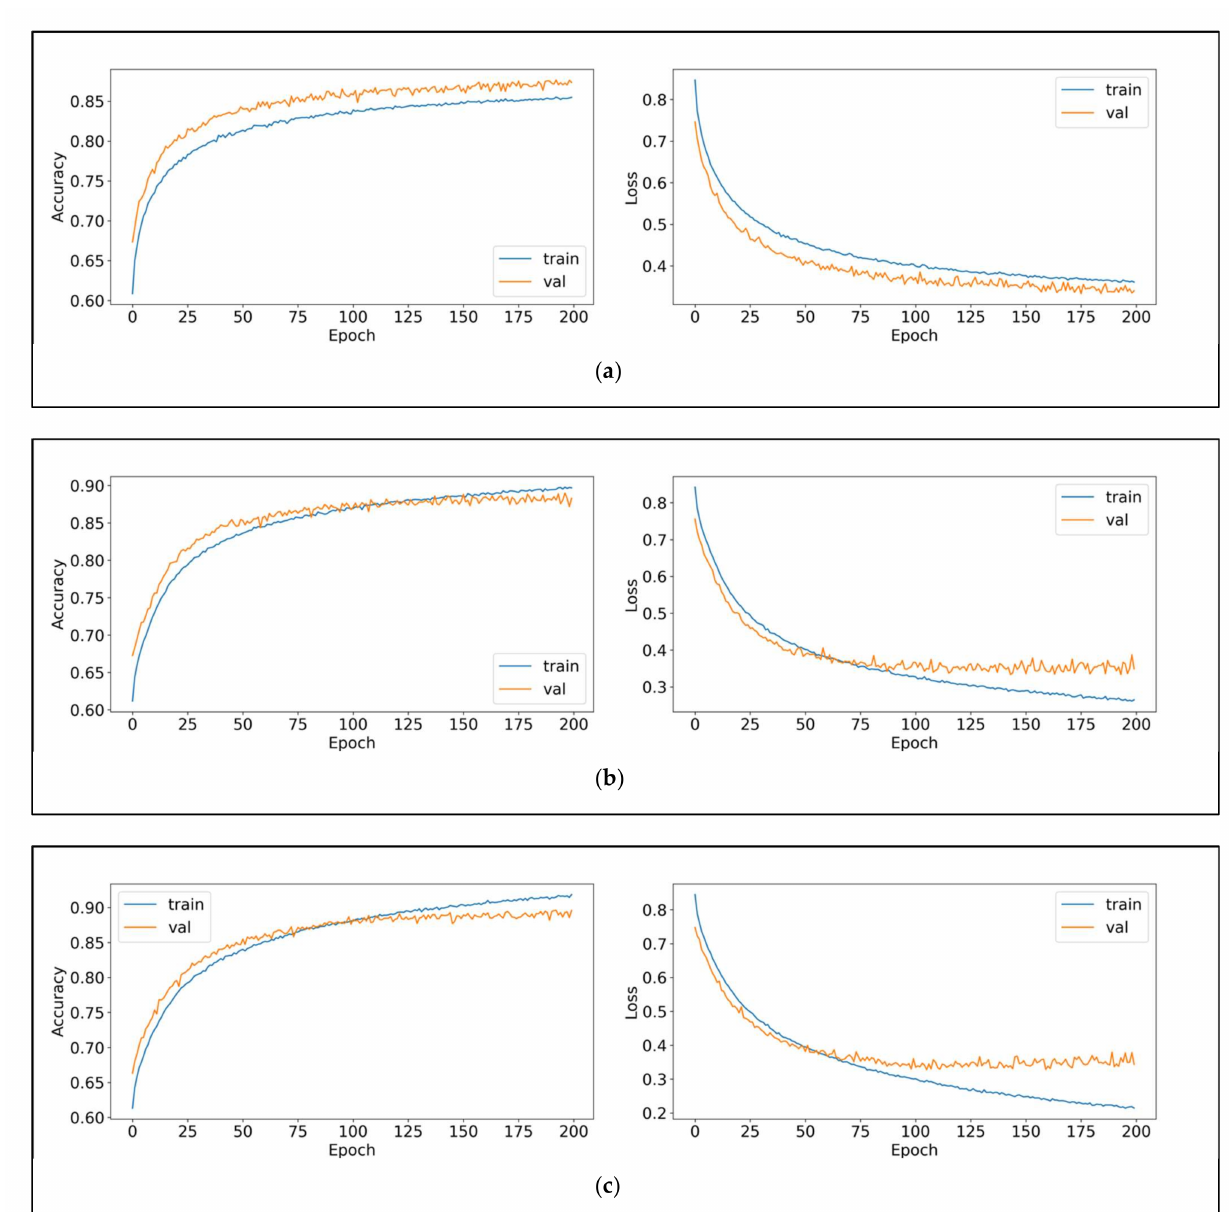
Figure 9. Training accuracy and training loss of the LSTM using fastText embedding: ( a ) single-layer architecture; ( b ) double-layer architecture; ( c ) triple-layer